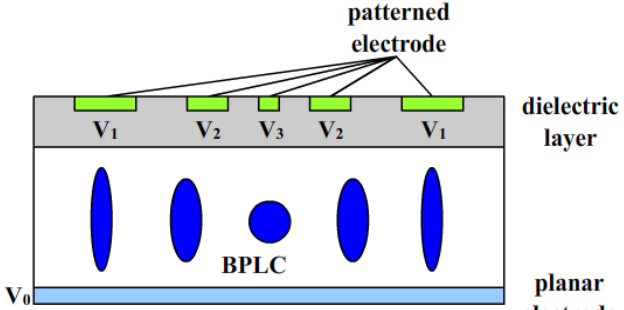
Figure 14. The cross section of a PS-BPLC microlens with multiple